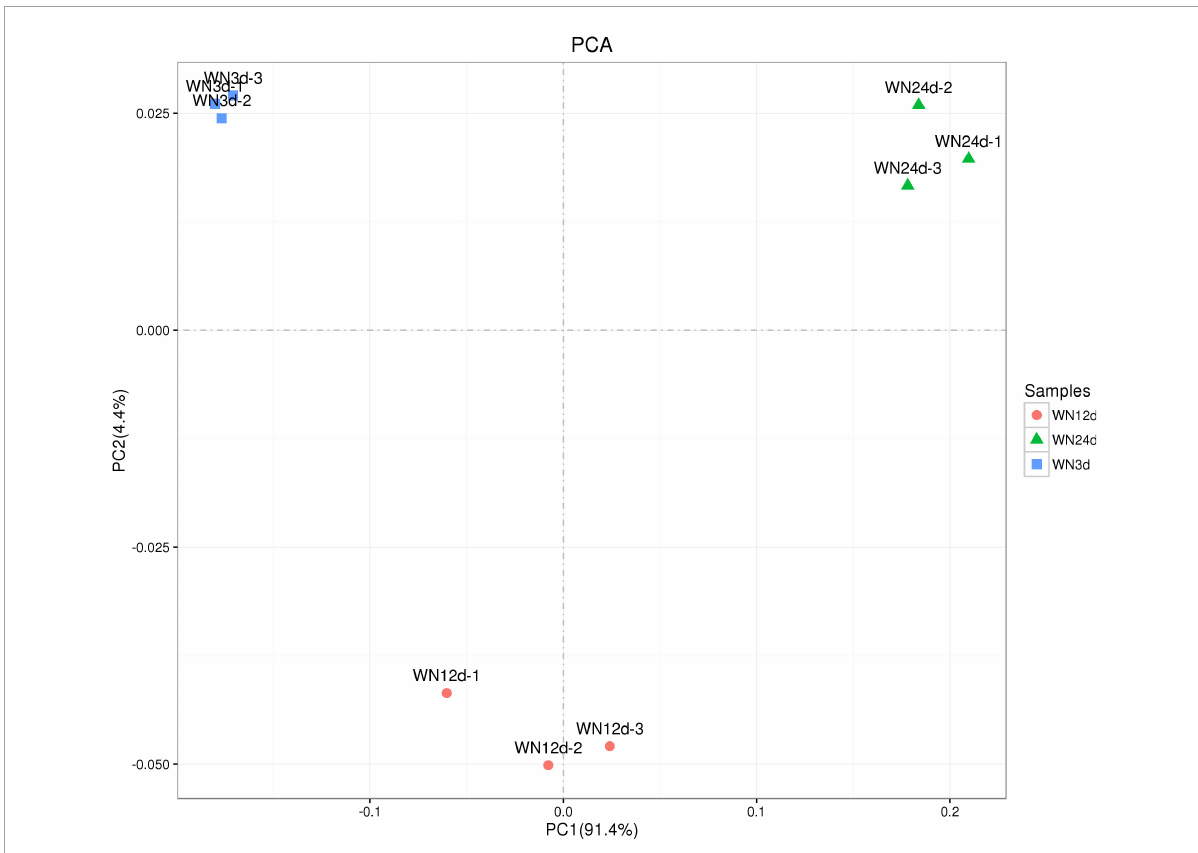
FIGURE4 Principal component analysis (PCA) analysis on the similarity of bacterial communities during the composting process.